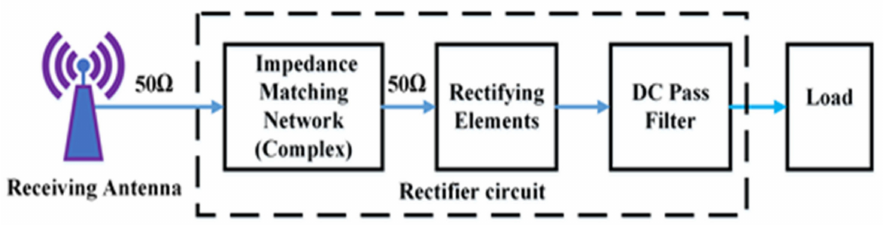
Figure 1. Basic block diagram of RF energy harvesting